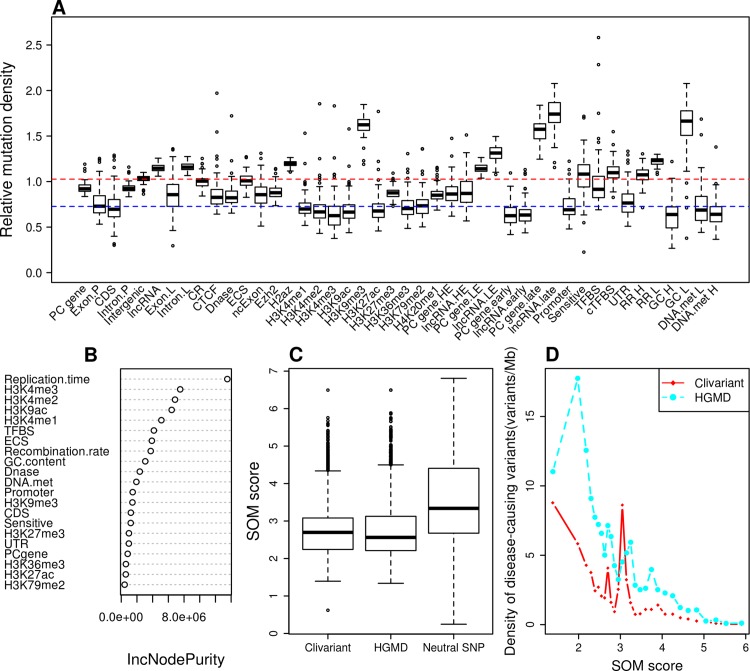
Construction of the Somatic Mutation (SOM) model for liver cancer.
A. Relative density of somatic mutations from whole genome sequences of 88 liver tumors [11], associated to different genome features (see Methods for feature details). Mutation density is normalized so that the whole genome average has a mutation density of 1. PC gene: protein coding gene; CDS: coding sequence; Exon.P, Intron.P, Exon.L,Intron.L are exon and intron of protein coding gene and lncRNA respectively; CR: conserved region; DNase: DNase I hypersensitive site; ECS: evolutionarily conserved structure; ncExon: non-coding exon; PC gene.HE, LncRNA.HE, PC gene.LE and LncRNA.LE are high expressed and low expressed protein coding gene and lncRNA; PC gene.early, LncRNA.early, PC gene.late and LncRNA.late are early and late replicated protein coding gene and lncRNA; cTFBS: conserved transcription factor binding site;RR H,RR L,GC H,GC L,DNA.met H and DNA.met L are 1-Kb windows with high recombination rate (> 4.0), low recombination rate (< 0.5), high GC content (GC % > 50%), low GC content (GC%<30%), high DNA methylation (average value > 0.7245) and low DNA methylation (average value < 0.4062) respectively; Blue and red dotted lines: base lines showing average values for CDS and intergenic regions, respectively; B: Feature importance as measured by IncNodePurity. We only show here features that passed feature selection. C. Distribution of SOM scores for neutral SNPs and for clinical variants from two disease-causing variants databases Clivariant and HGMD. Neutral SNPs here are SNPs from the 1000 Genome project with allele frequency higher than 0.01, SOM scores predicted by the random forest model were divided by the number of patients. D. Correlation of SOM score with densities of disease-causing variants. Genome positions were sorted by SOM score and split into 100Mb intervals. The plots show the average SOM score and density of disease-causing variants for each interval. The purple dotted line shows cutoff used for defining low SOM score thereafter.